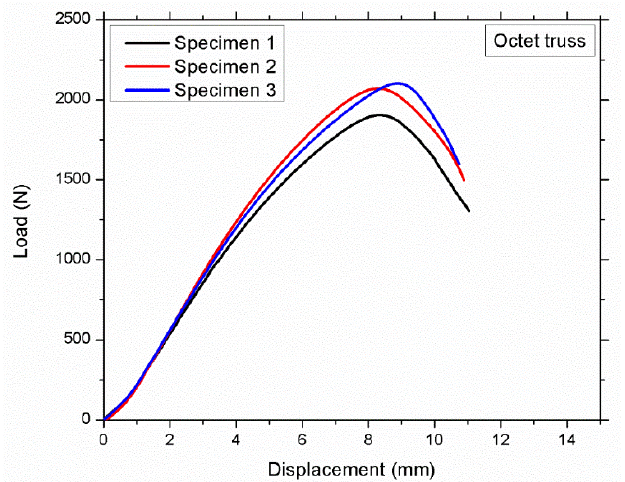
Figure 7. Octet truss structured specimens having mass of 30.92, 31.58, and 30.83 g, respectively, showing minor variations in critical buckling load.